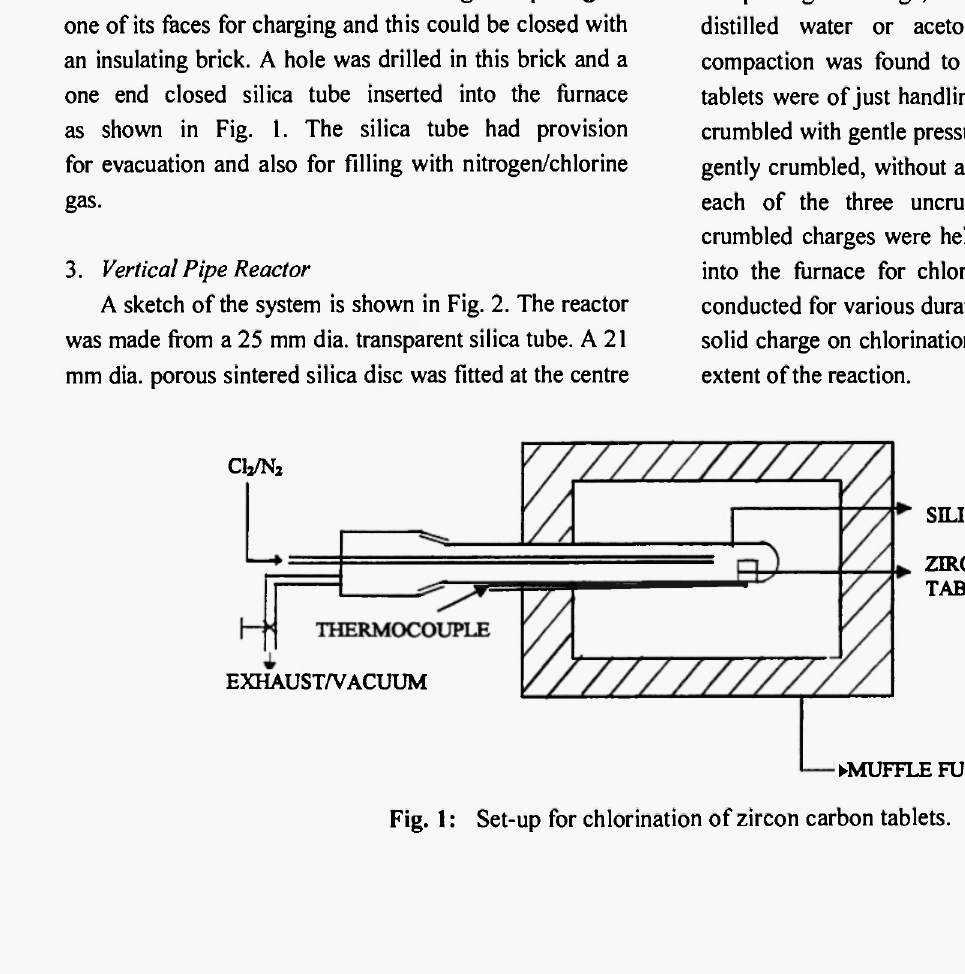
Fig. 1 : Set-up for chlorination of zircon carbon